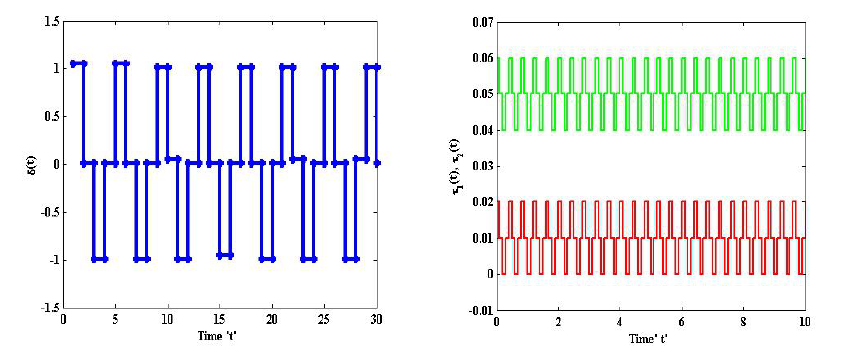
Figure 4. Simulation results of control input.